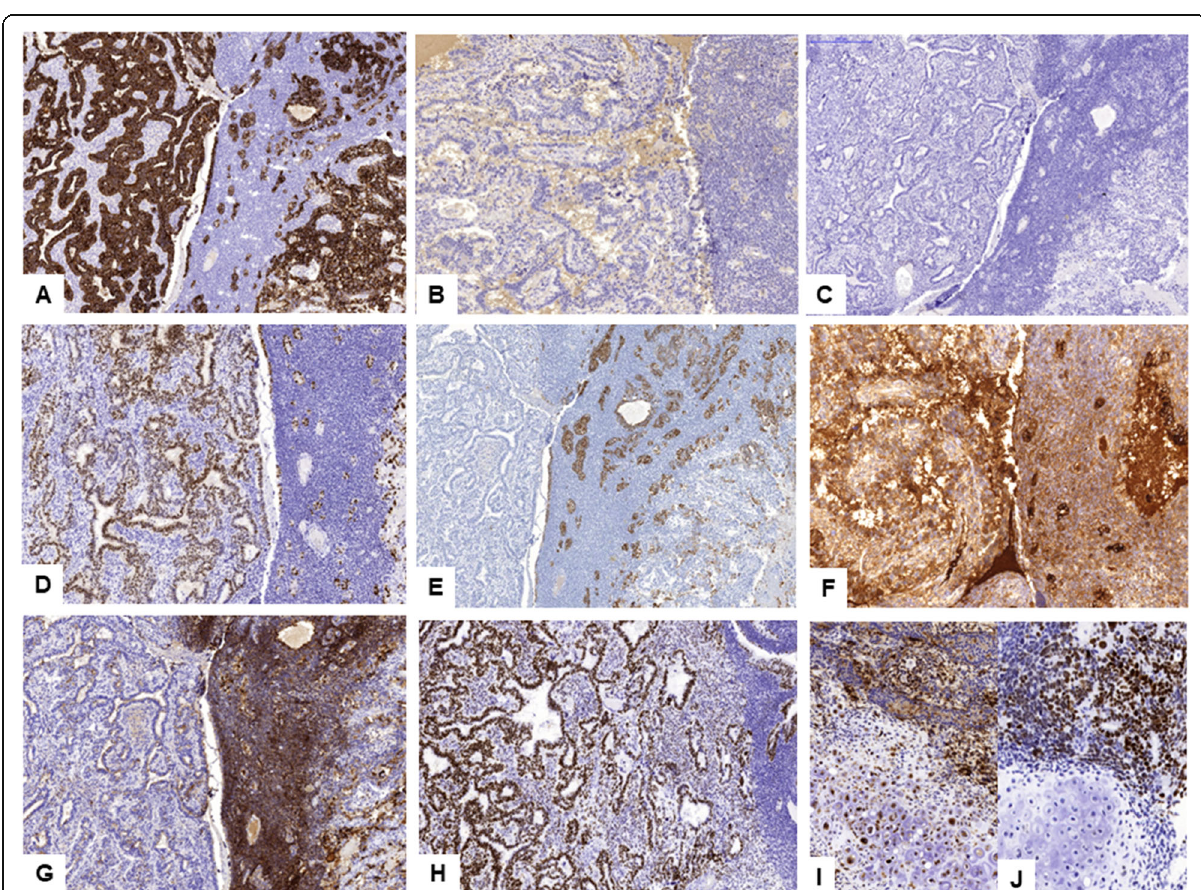
Fig. 3 Immunohistochemistry results for the surgical specimen of cystectomy. CK A1/A3 ( a ). EMA ( b ). CK7 ( c ). CDX2 ( d ). HepPar1 ( e ). AFP ( f ). GLP3 ( g ). SALL4 ( h ). GLP3 and SALL4 in sarcomatoid areas with chondroid differentiation ( i-j )